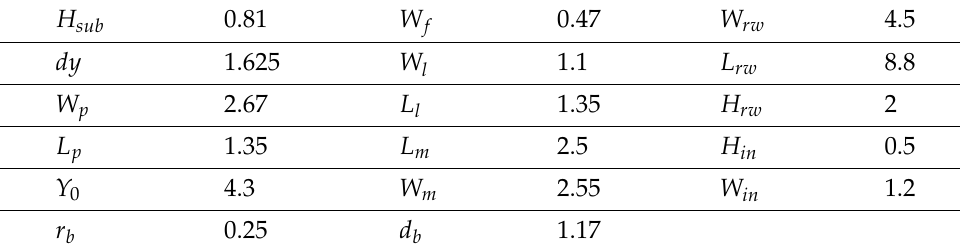
Table 1. Dimensions in millimeters of each designed parameter for the top-side transition.